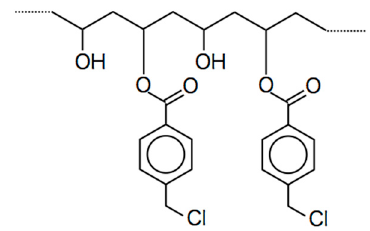
Figure 1. Structure of polyvinyl 4-(chloromethyl)benzoate.